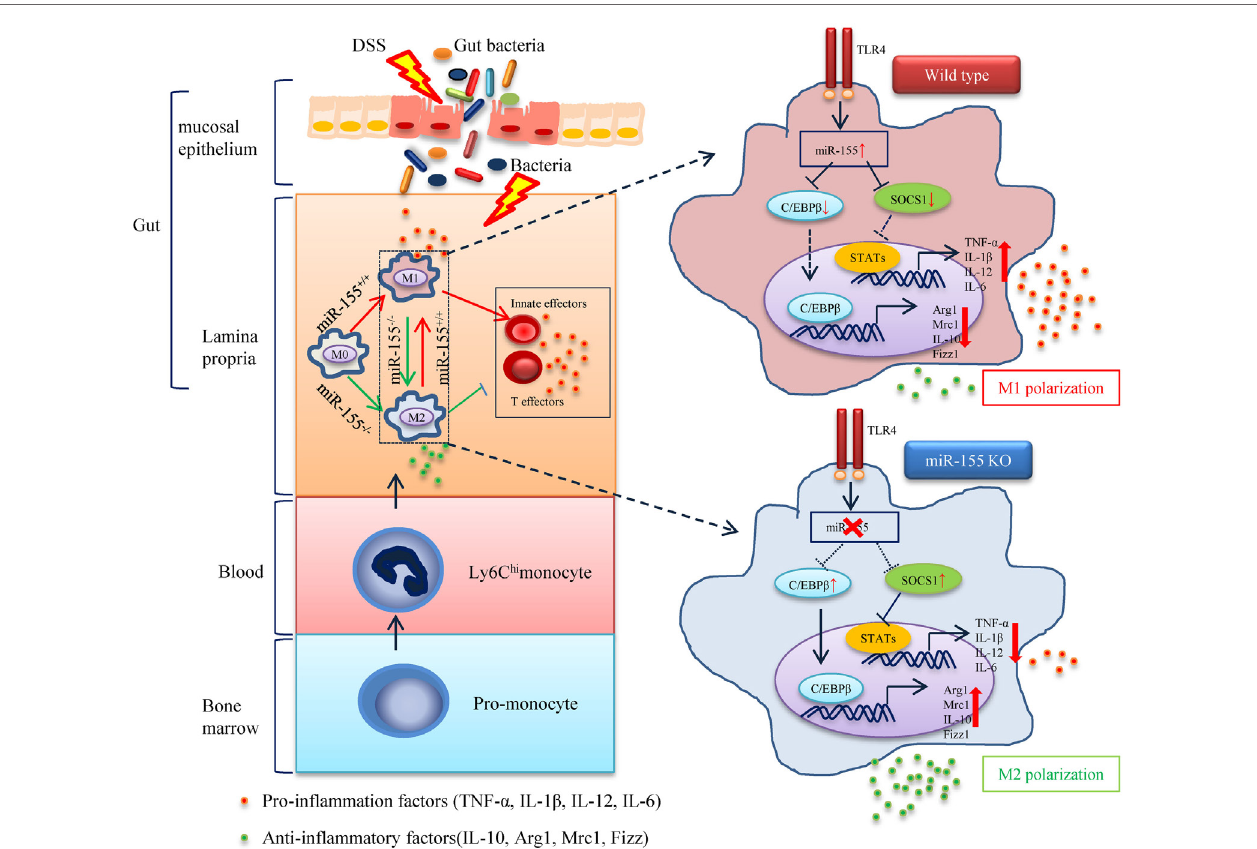
FigUre 8 | The proposed mechanism of miR-155 in the pathogenesis of dextran sulfate sodium (DSS)-induced colitis. In steady state, resident macrophages maintain tolerance toward the intestinal microbiota. Upon DSS exposure, gut bacteria break through the intestinal mucosal barrier and inflammatory macrophages are recruited from blood monocytes and accumulate in the inflamed mucosa, where they produce pro-inflammatory mediators. While in the absence of miR-155, two target genes C/EBP β and SOCS1 in Ly6C hi monocytes are unregulated and functional. This leads to the undifferentiated M0 macrophages shifting to the M2 phenotype in a PGE2-dependent manner, with a reduced M1 gene program expression and an enhanced M2 gene program expression. The miR-155 deficiency forced M2-like dominant macrophages in lamina propria to shape the colon environment and condition the proliferation and polarization of T cells, which facilitated the maintenance of intestinal homeostasis and resolved the pathogenesis of DSS-induced